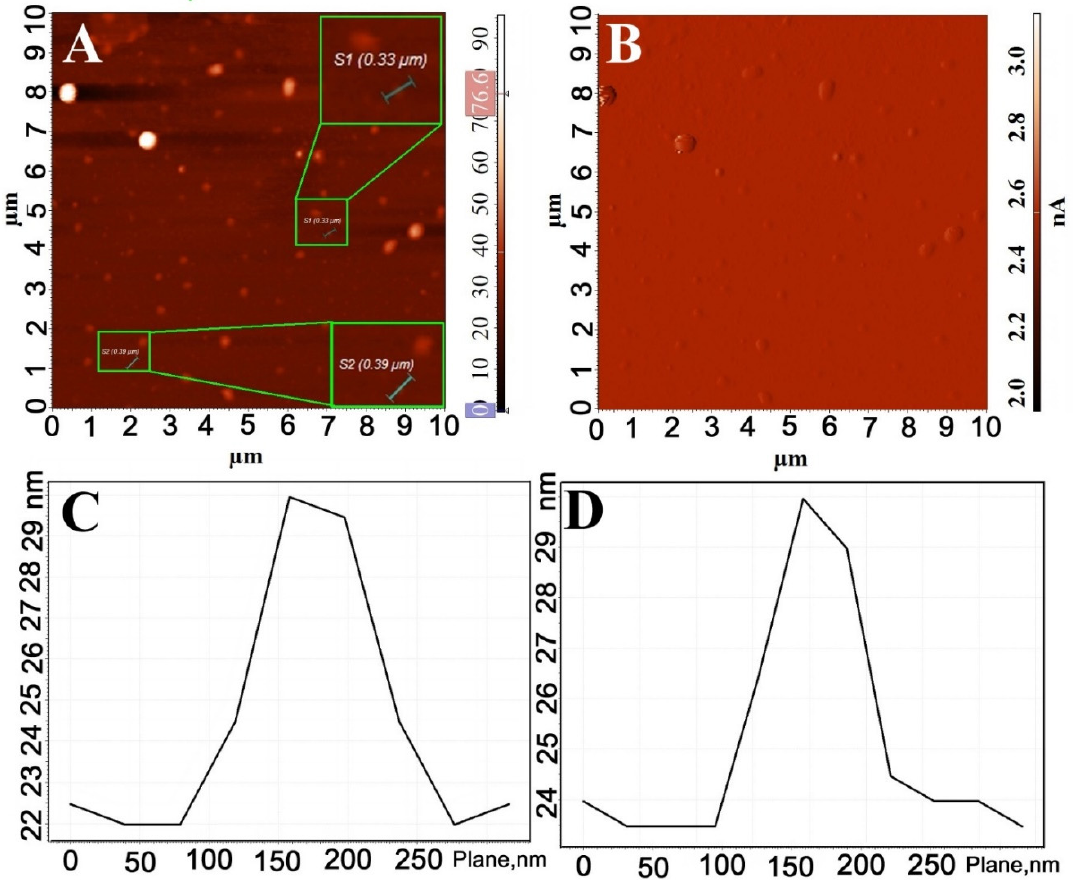
Figure 3. ( A ) AFM height image of the round-shaped particles formed by drop-casting an EDOT-PCL solution in Chl; ( B ) AFM amplitude image; ( C , D ) cross-sectional analysis of the particles shown in magnified insets in ( A ): ( C ) S1 section and ( D ) S2 section.